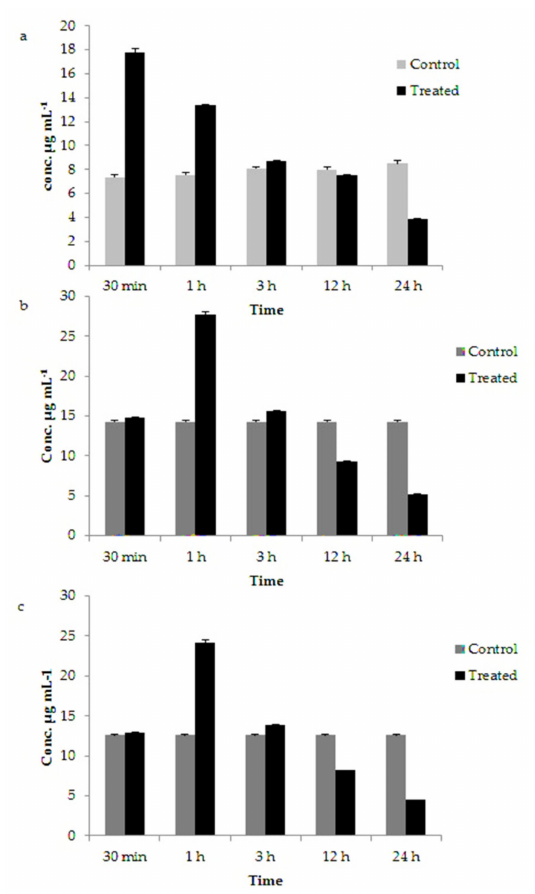
Figure 8. Variations in chlorophyll ( a ), carotenoids ( b ) and fucoxanthin ( c ) content in gold-treated N. shiloi at different time points such as 30 min, 1 h, 3 h, 12 h and 24